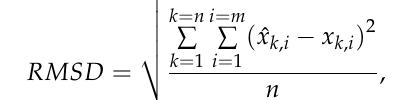
Prony Figure 3. Comparisons of average estimation errors.